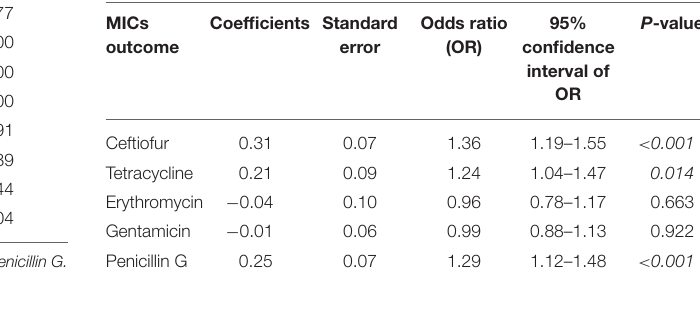
TABLE 5 | Changes in MICs of antimicrobial agents among Streptococcus uberis ( n = 228) isolates from dairy cattle with bovine mastitis in northern Thailand during 2010–2017. Antimicrobial